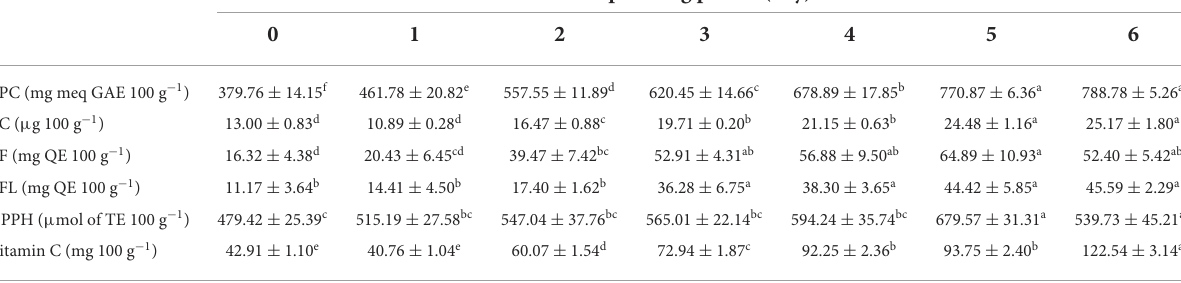
TABLE 1 Total phenolic, carotenoids, flavonoids, flavonols contents, and potential antioxidant capacities of L. culinaris during sprouting at 20 ± 1 ◦ C and 90–93% RH (mean ± SE), n = 6.